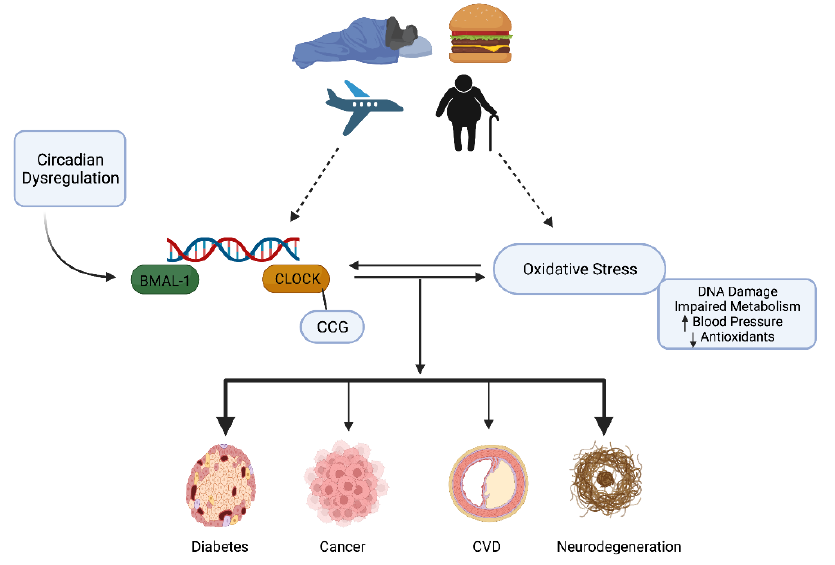
Figure 3. The interplay between Circadian and Redox Biology: Oxidative Stress and Disrupted Circadian Rhythms. A proposed bidirectional relationship exists between oxidative stress and circadian dysregulation whereby external factors and behaviours that disrupt circadian rhythms (jet lag, the ageing process, and regular consumption of certain foods) may also induce oxidative stress and, likely vice versa. The result is a deterioration of normal physiological functions (DNA damage, increased blood pressure, and insulin resistance) and control that increases the risk for chronic dis- eases.